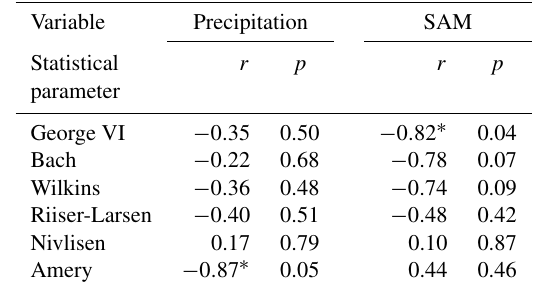
Table 1. Results of the statistical correlation analysis between frac- tional lake extents and previous-year precipitation as well as annual Southern Annular Mode (SAM), with r reflecting the Pearson cor- relation and p the p value describing statistical significance. Due to the low number of observations used for correlation, the p value might not be representative, and rather r should be used for inter- pretation. Statistical significance levels of p < 0 . 05 ( ∗ ), p < 0 . 01 ( ∗∗ ) and p < 0 . 001 ( ∗∗∗ ) are